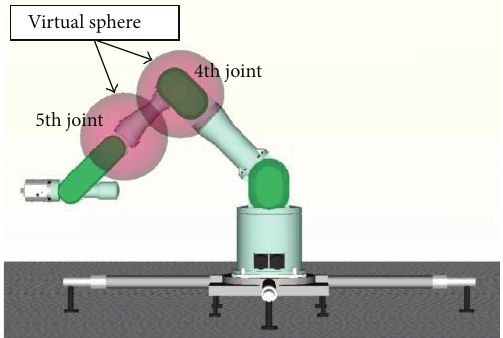
Figure 3: Virtual spheres with radius 𝐿 min in the 4th and 5th joints.